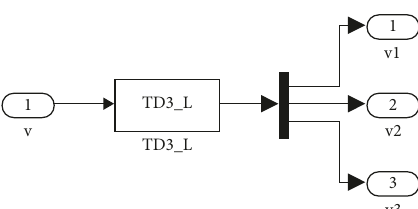
Figure 12: Modular composition of the tracking differentiator subsystem.